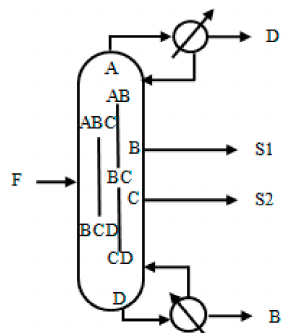
Figure 1. The extended Petlyuk dividing wall distillation column